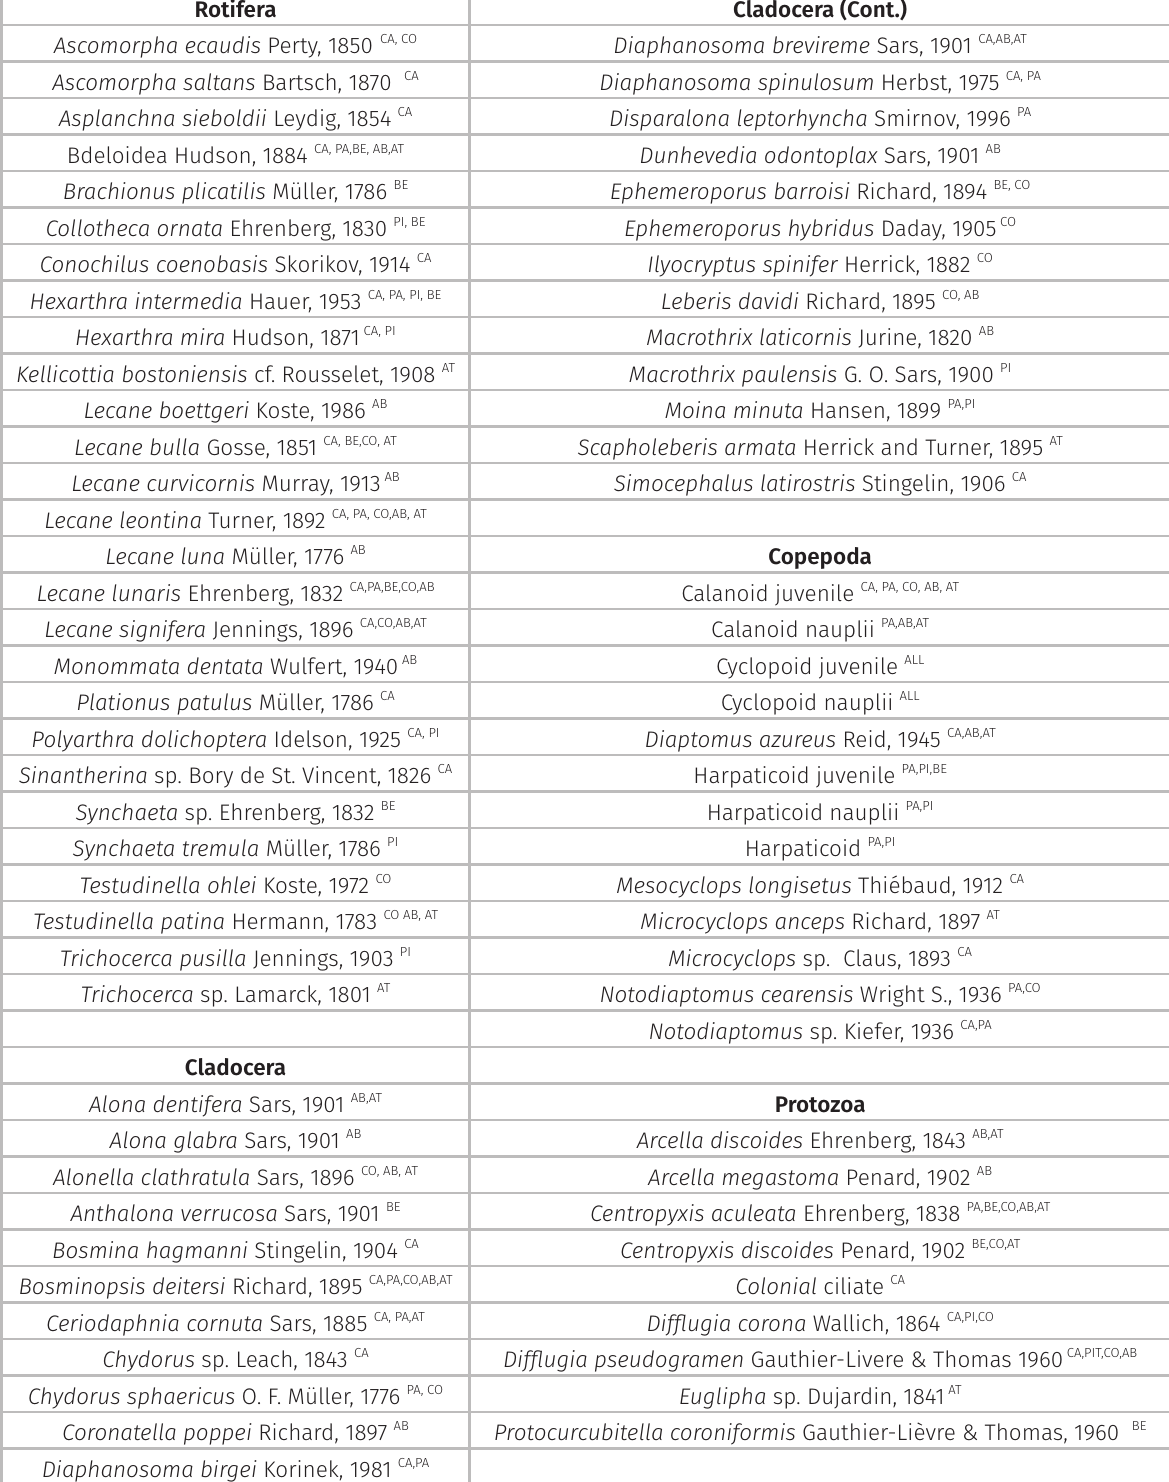
Table II. Zooplankton species inventory in all analyzed environments. CA = Cabiúnas; PA = Paulista; PI= Pitanga; BE= Bezerra; CO= Comprida; AB= Amarra-boi, AT= Atoleiro and ALL = all sampled environments. Rotifera Cladocera